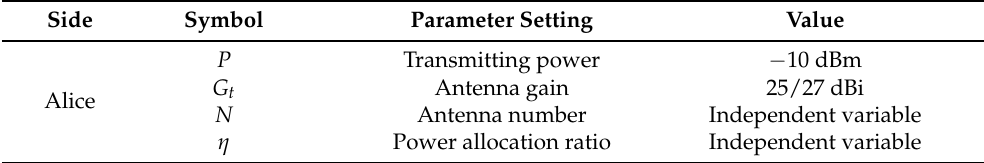
Table 1. Parameter